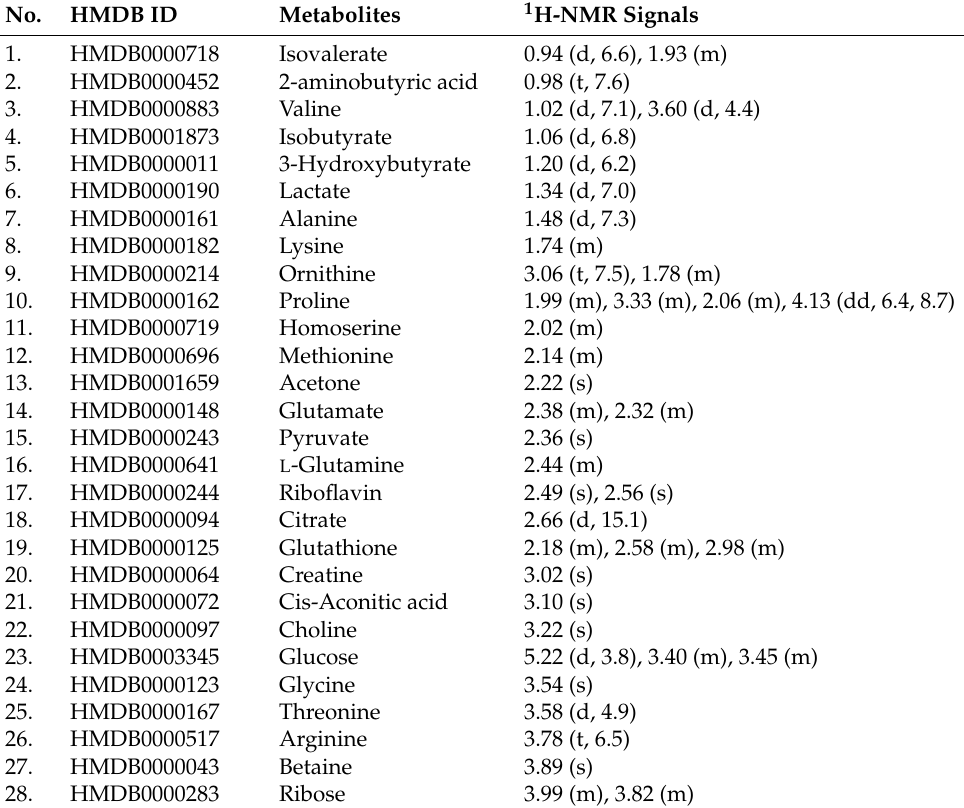
Table 1. 1 H-NMR characteristic signals of the identified metabolites in the red blood cells.